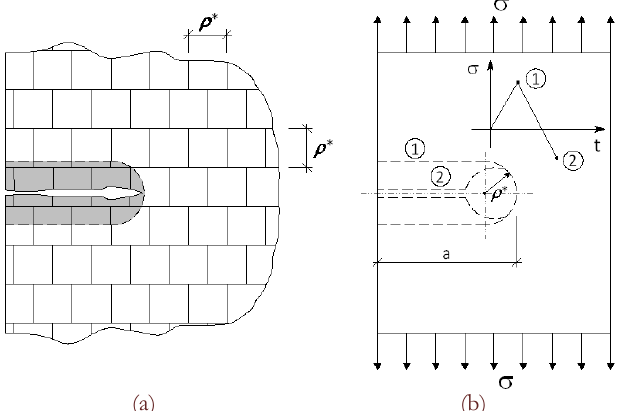
Figure 1: Crack configuration according to the UniGrow model: a) crack and the discrete elementary material blocks; b) crack geometry at the tensile maximum and compressive minimum loads